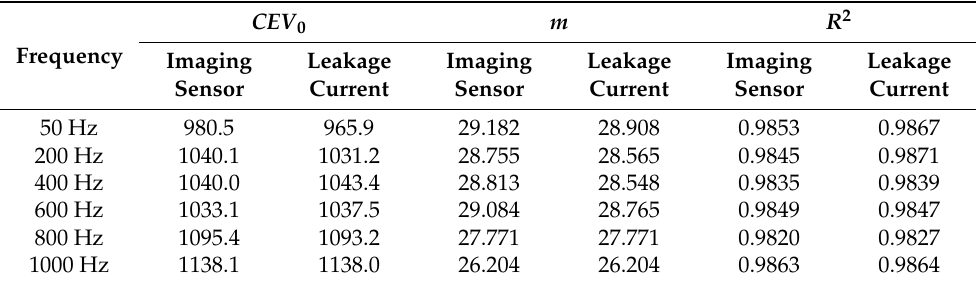
Table 3. Linear fit parameters CEV = CEV 0 + m · P , where CEV 0 is the CEV at zero pressure in Volt, m is the slope in Volt/kPa and P is the pressure in kPa.